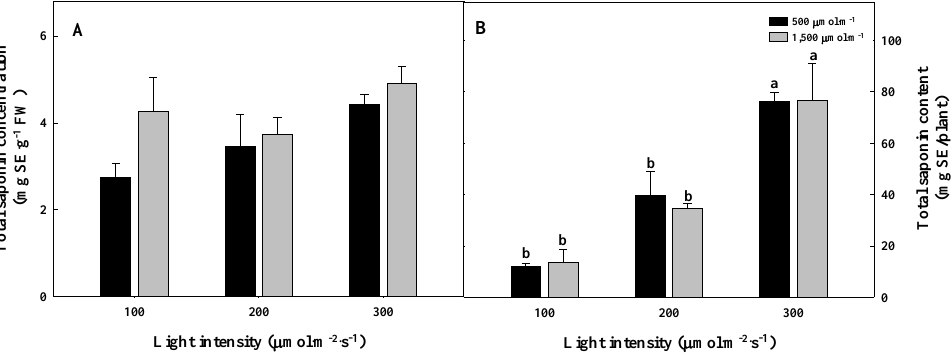
Figure 7. The different total saponin concentration ( A ) and content per biomass ( B ) of Glehnia littoralis Fr. Schmidt ex Miquel shoots, as affected by various CO 2 concentrations and light intensities after 56 days of treatment. The vertical bars represent the standard deviation of the mean ( n = 3). Different letters above bars indicate significant differences at p ≤ 0.05, using Tukey’s multiple range test.